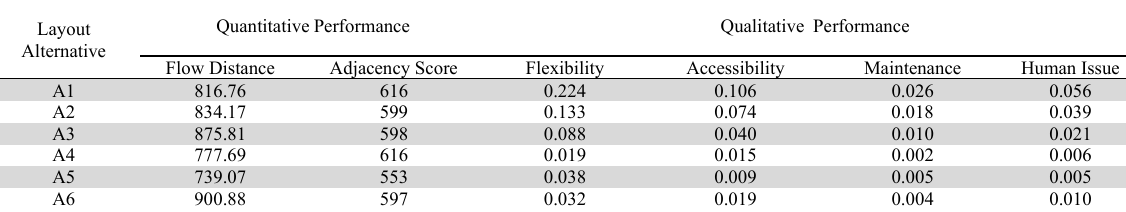
Performance measures values for layout alternatives Quantitative Performance Layout Alternative